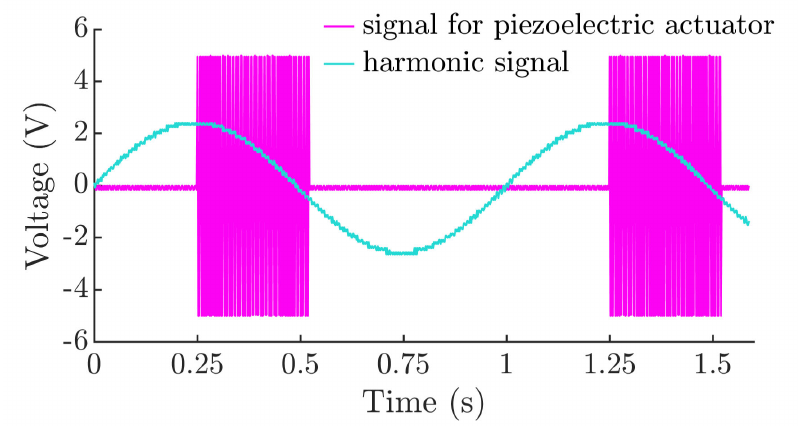
Figure 4. Oscillogram of the synchronized signals of piezoelectric actuator excitation and harmonic excitation when φ = 5 π /9, λ = π /8, and ω = 62.83 rad/s.